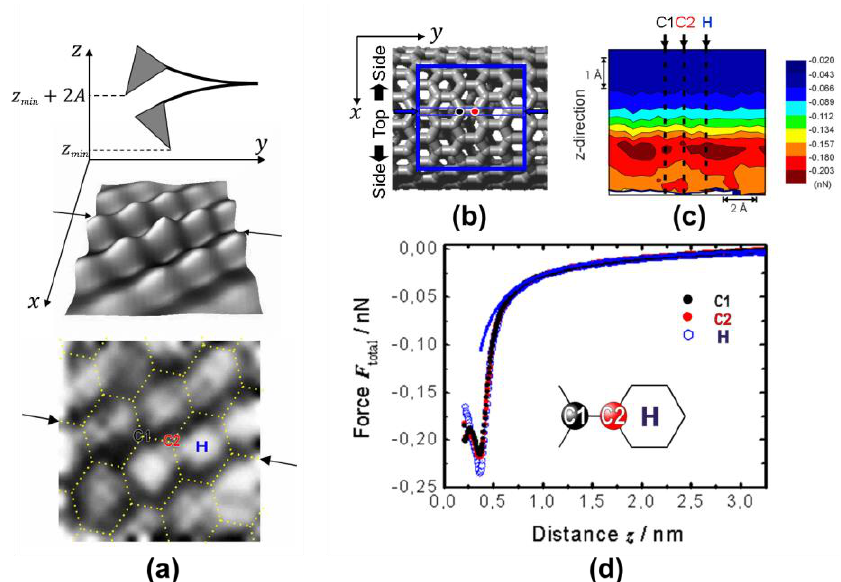
Figure 2. ( a ) Schematic illustration of a 3D-FFS measurement over the topmost 1 × 1 nm 2 area of the SWNT as depicted in ( b ). The upper (3D) and lower (2D) images in (a) are the surface topographies obtained before and during the measurement, respectively. The elongation of the honeycomb structure (dotted line) can be explained geometrically by assuming a point-like tip scanning across a curved surface (see text). ( c ) 2D force field map obtained along the line indicated by a pair of counter arrows in (a). ( d ) Force vs. distance relationships along the dashed lines in (c), corresponding the C1, C2, and H sites marked in (a) and (c) (for details see text).